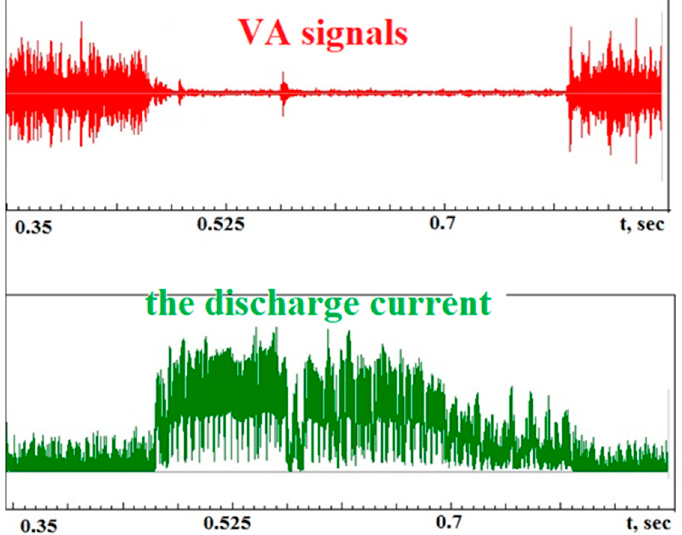
Figure 14. Recording of the VA signals and the discharge current at the site of a short circuit during Al 2 O 3 -30%TiC ceramics electrical discharge machining. Al 2 O 3 -30%TiC ceramics electrical discharge